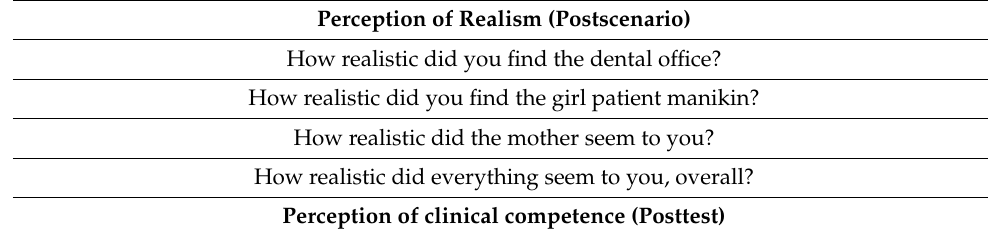
Table 1. Questionnaire applied for students’ evaluation of scenario